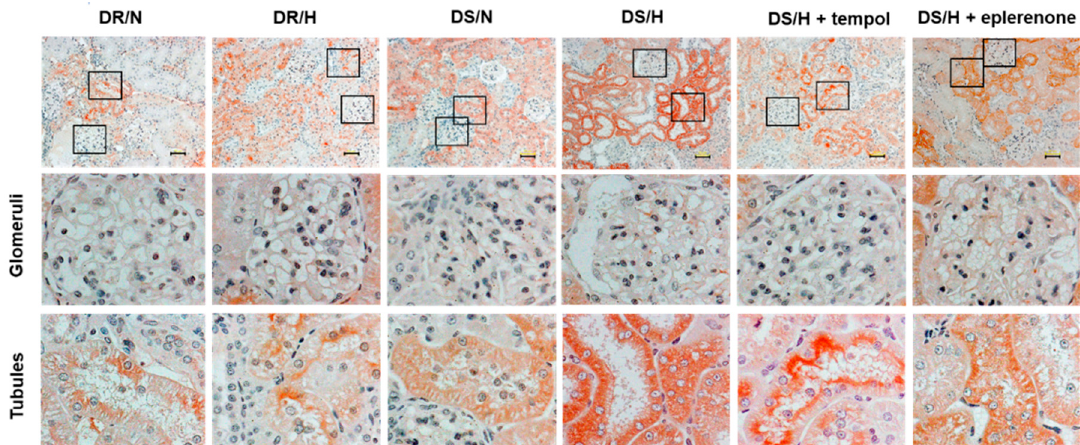
Figure 3. Immunohistochemistry of vanin-1 in rat kidney tissues. Representative images of kidney cortical regions. Magnified views of glomeruli and tubules are from the indicated black boxes. Vanin-1 expression was localized both around the injured tubules and within a subset of injured tubules, but not in the glomeruli. Scale bar, 50 μ m.